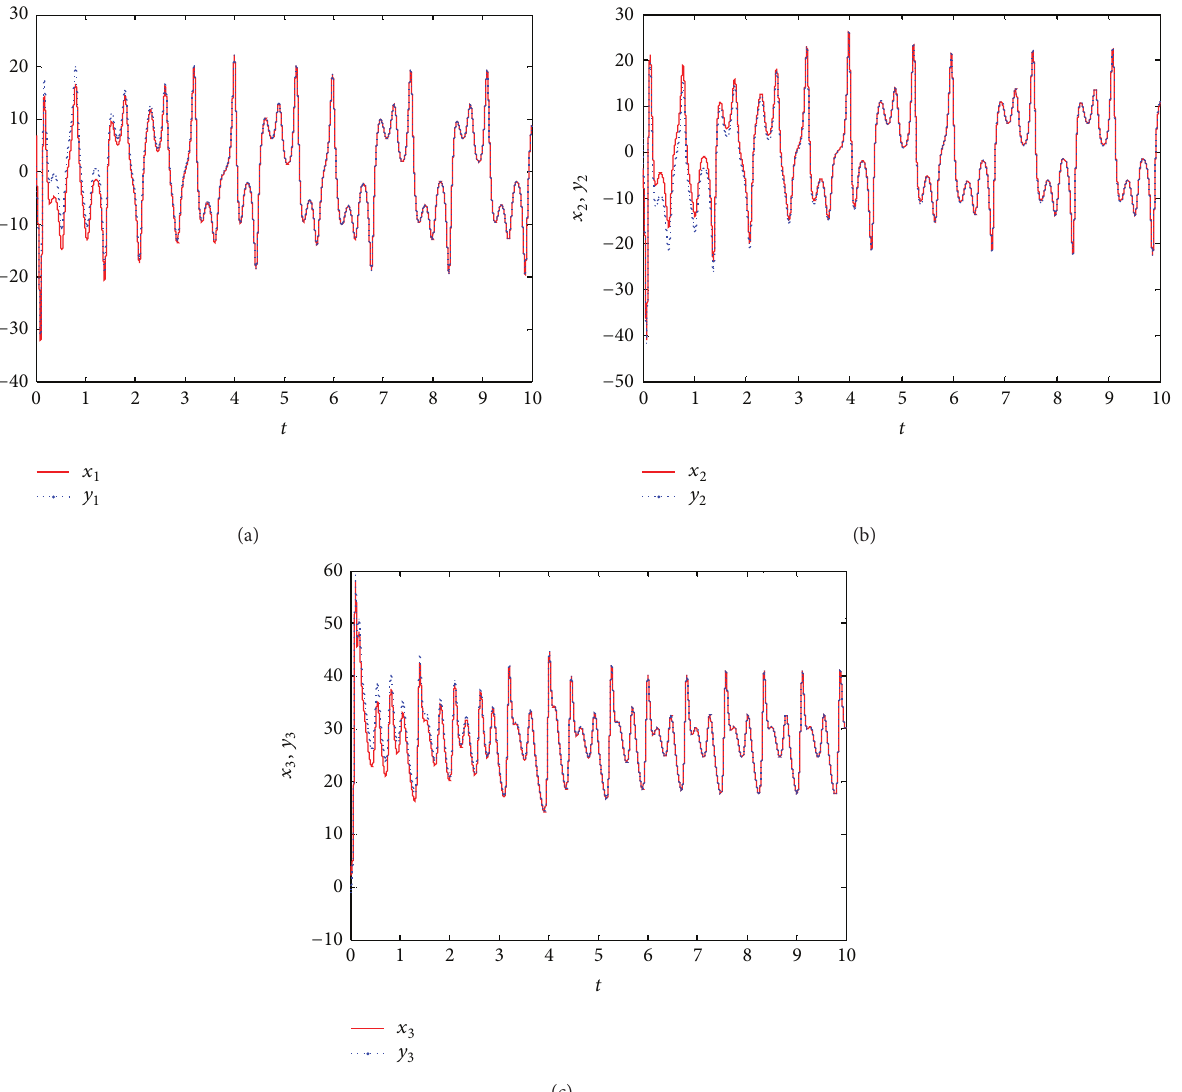
Figure 1: (a) The state trajectories of the system (26) and system (31) with the sliding mode control method. (Signals 𝑥 1 ;𝑦 1 ). (b) The state trajectories of the system (26) and system (31) with the sliding mode control method. (Signals 𝑥 2 ; 𝑦 2 ). (c) The state trajectories of the system (26) and system (31) with the sliding mode control method. (Signals 𝑥 3 ;𝑦 3 ).